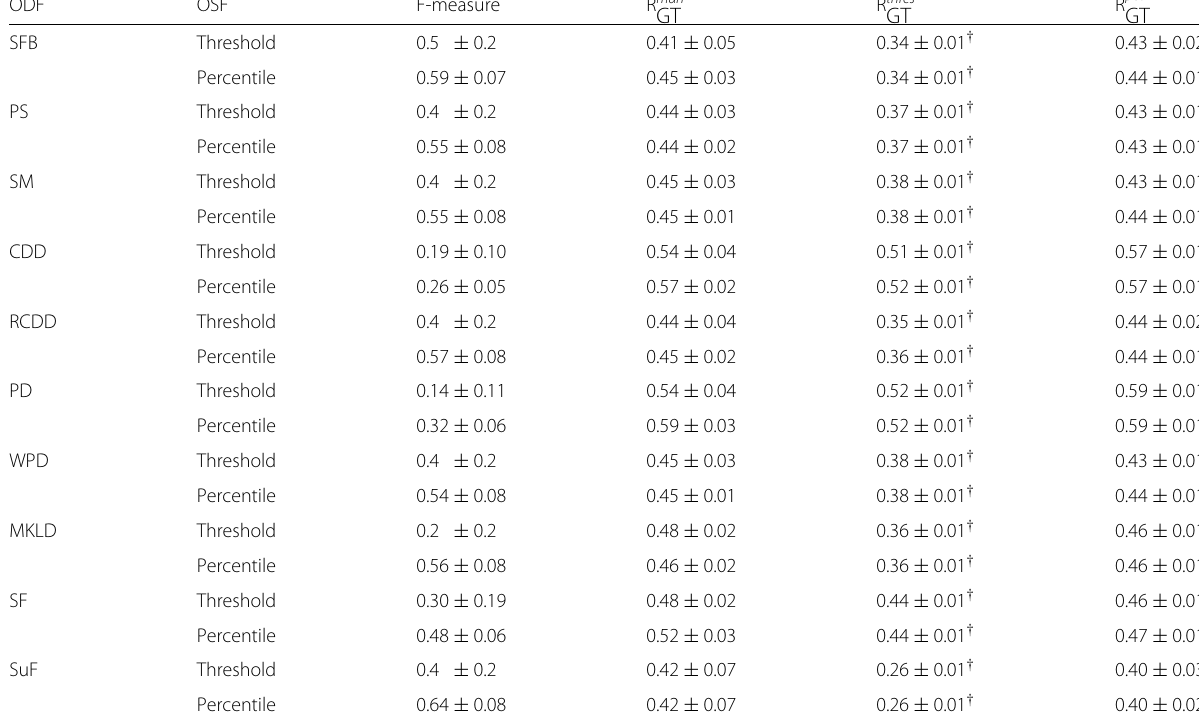
Table 3 Comparison of the user effort invested in correcting the initial estimation of static onset detectors in terms of the R GT . The F-measure column shows the performance of the static detection method, whereas R man considering a complete manual correction of the results. R thres percentile-based correction approaches, respectively